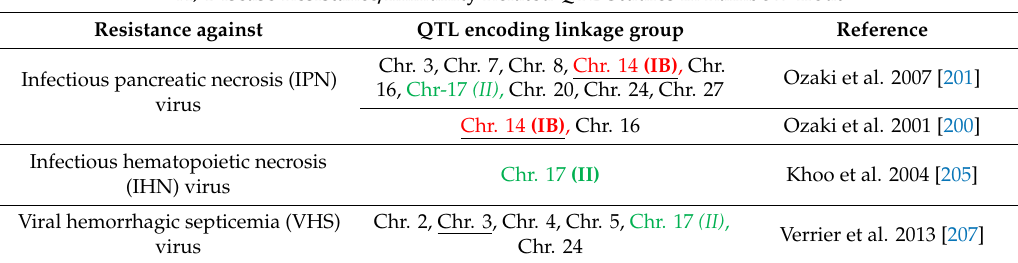
Table 2. List of genome-wide QTL studies in rainbow trout and Atlantic salmon that investigated disease resistance or other immune traits. QTL are listed as described in the respective references, with the most important QTK underlined; double underlining is used if among the important QTL one was found especially important. Red font (IB) and green font (II) indications are used to indicate chromosomes with the IB region and the classical MHC class II locus, respectively. Indications of (IB) or (II) in bold font refer to the respective locus being located within the confidence interval region mapped to only a part of the chromosome in the respective study, Italic font refers to them being located outside that confidence interval region, and if in normal font we were unable to asses that matter. The IA regions with classical MHC class I map to rainbow trout Chr. 18 and to Atlantic salmon Chr. 27, but those chromosomes were not found to harbor QTL in the listed